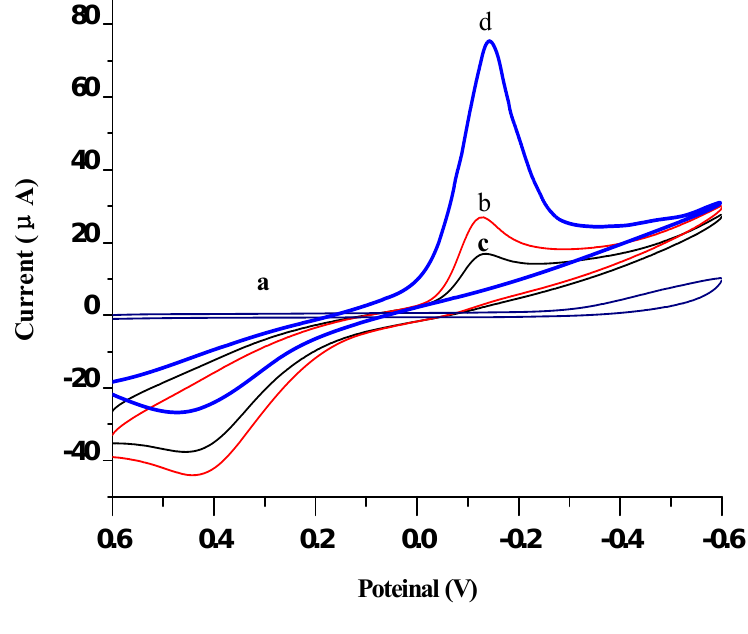
Figure 5. Cyclic voltammograms obtained at ( a ) SPCE/MNPs-p24 Ab1 electrode in pH 7.0 PBS; ( b ) SPCE/MNPs-p24 Ab1; ( c ) SPCE/MNPs-p24 Ab1 incubated in 5 ng/mL p24; and ( d ) c was further sandwich immunoreacted in Au NPs/EV-p24 Ab containing 5 mmol/L HQ and H O 2 2